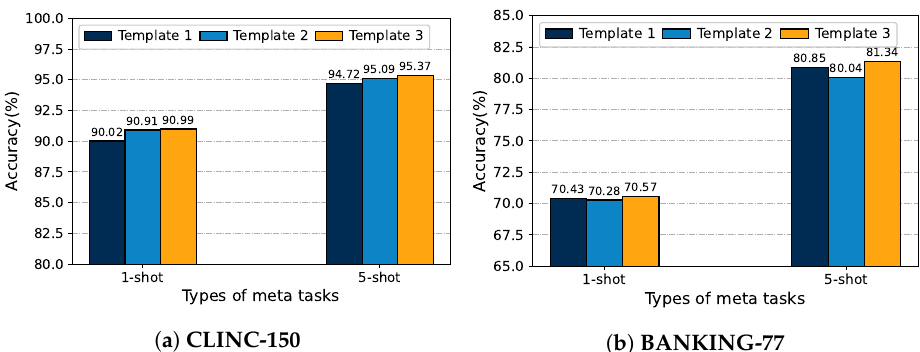
Figure 2. Performances of different templates in “5-way 1-shot” and “5-way 5-shot” meta tasks on CLINC-150 and BANKING-77